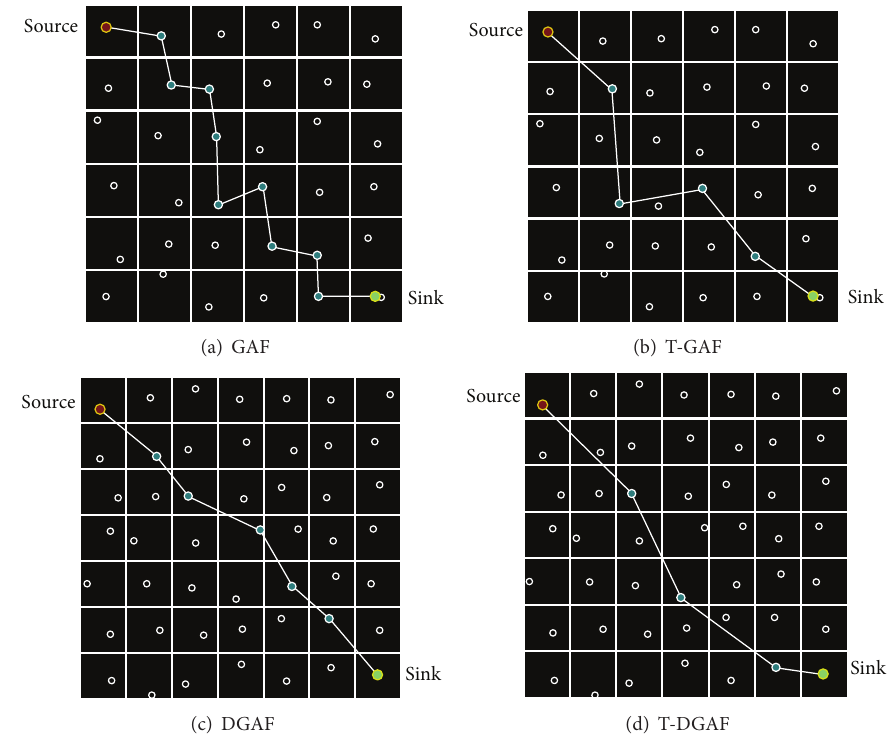
Figure 6: Simulation topology showing data transmission from the source to the sink.